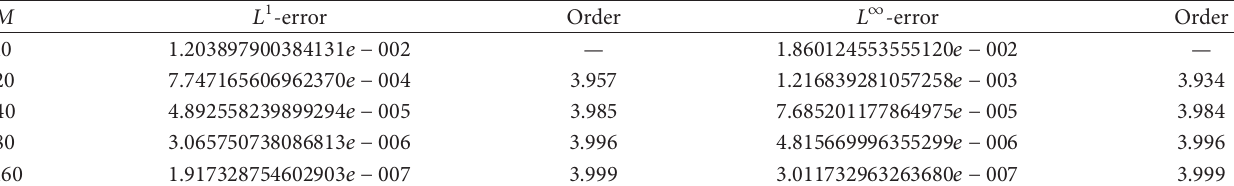
Table 1: Initial value problem (30) and 𝐿 1 and 𝐿 ∞ norms of the